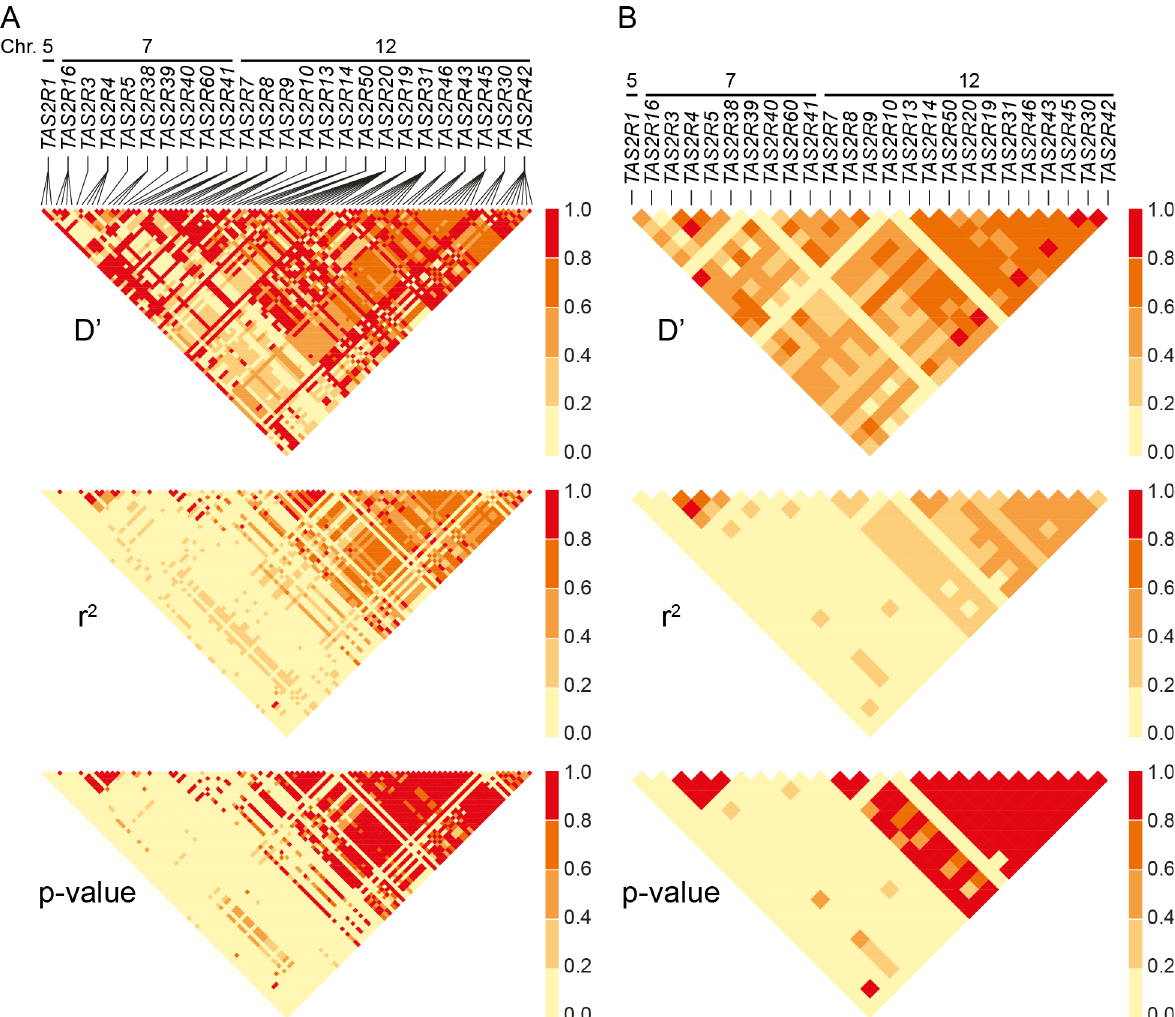
Fig 4. Linkage disequilibrium across SNPs and genes. (A) Pairwise D ’ , r 2 and corresponding p-values between cSNPs, and (B) between TAS2R s. Chromosomal assignments are specified. Long-range haplotypes identified in block analyses are located in the conspicuous high LD regions of TAS2R7 - TAS2R42 , and TAS2R3 - TAS2R38